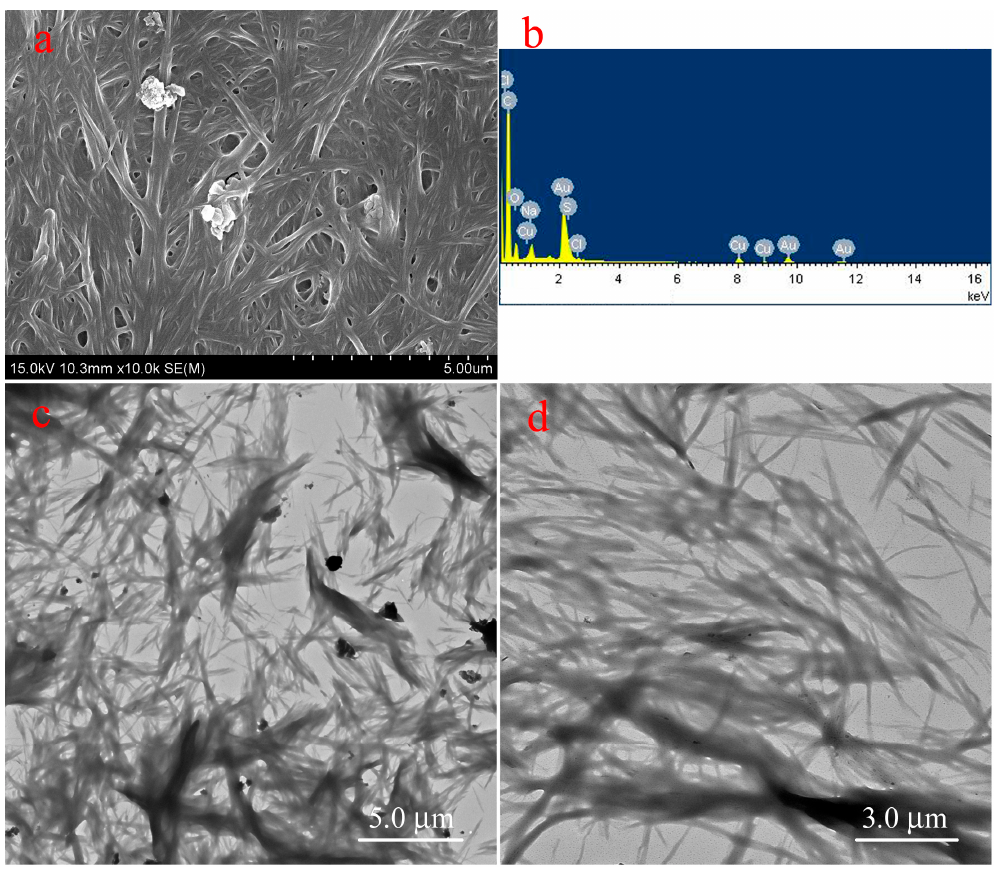
Figure 9. Scanning electron microscope (SEM) ( a ) and transmission electron microscope (TEM) ( c ) images of TC16-Fl xerogels from gels in n-pentanol with the addition of CR (2 mg/mL) in comparison with TEM image ( d ) of same gel without CR. Image ( b ) indicate energy dispersive X-ray spectroscopy (EDXS) taken on the nanoparticle shown in picture ( a ).